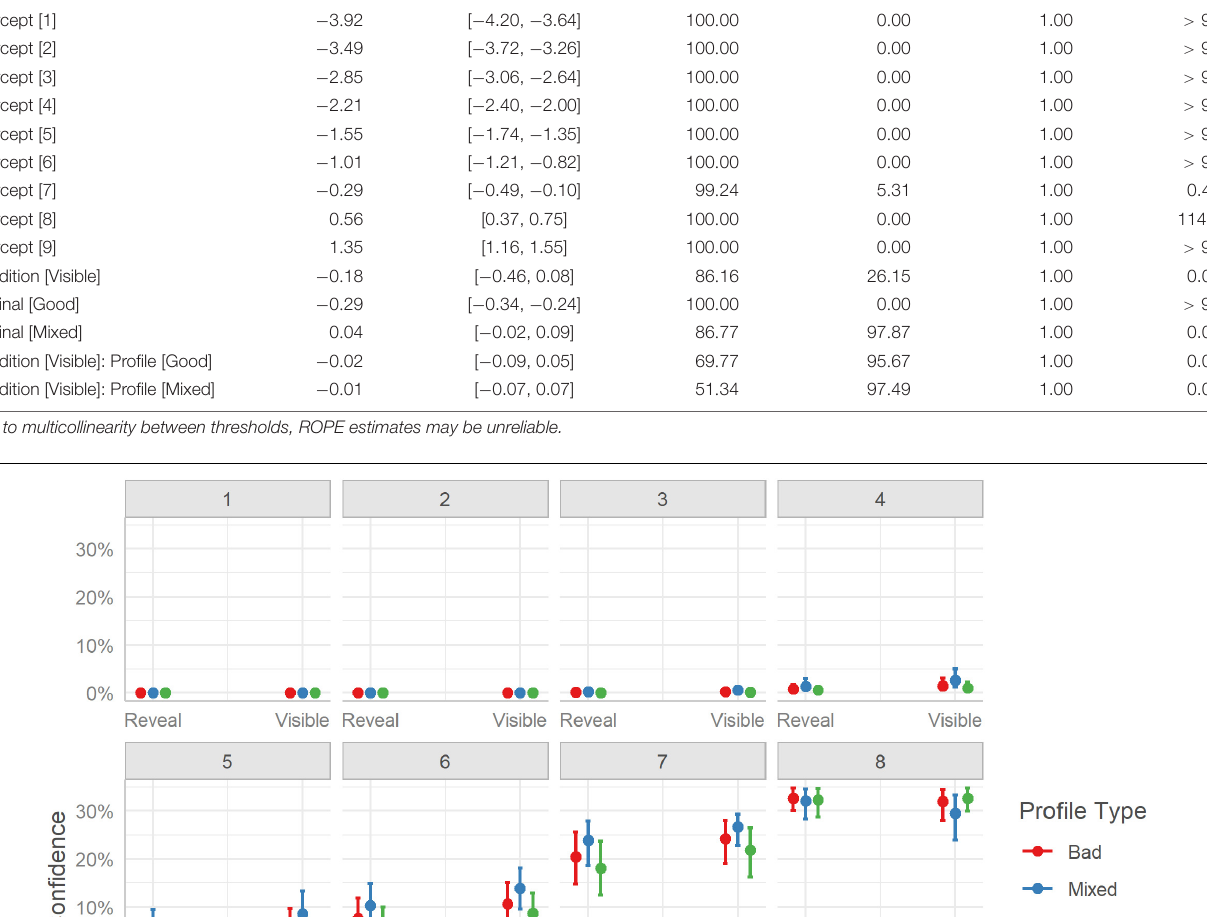
TABLE 4 | Summary of the model fitted to the judgment confidence data, considering the experimental condition (Visible or Reveal) and Profile type (Good, Mixed, and Bad). β 89% HDI